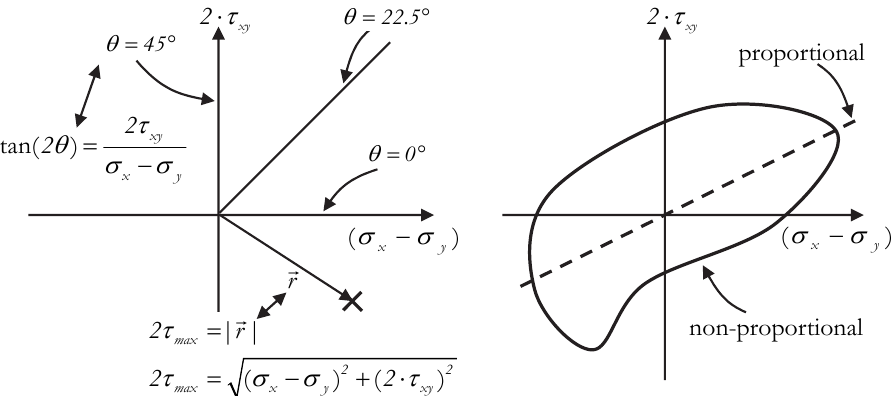
Figure 1: Interpretation of the tresca-diagramm (left) and non-proportional path